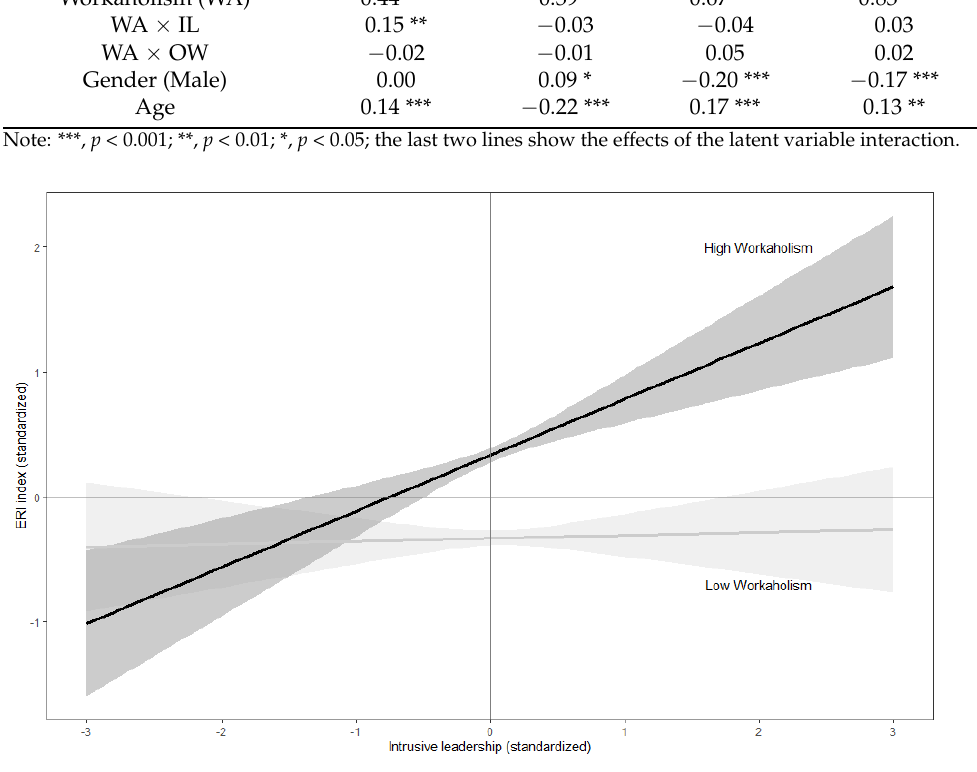
Figure 2. Mediating effect of workaholism on the association between intrusive leadership and effort/reward imbalance .